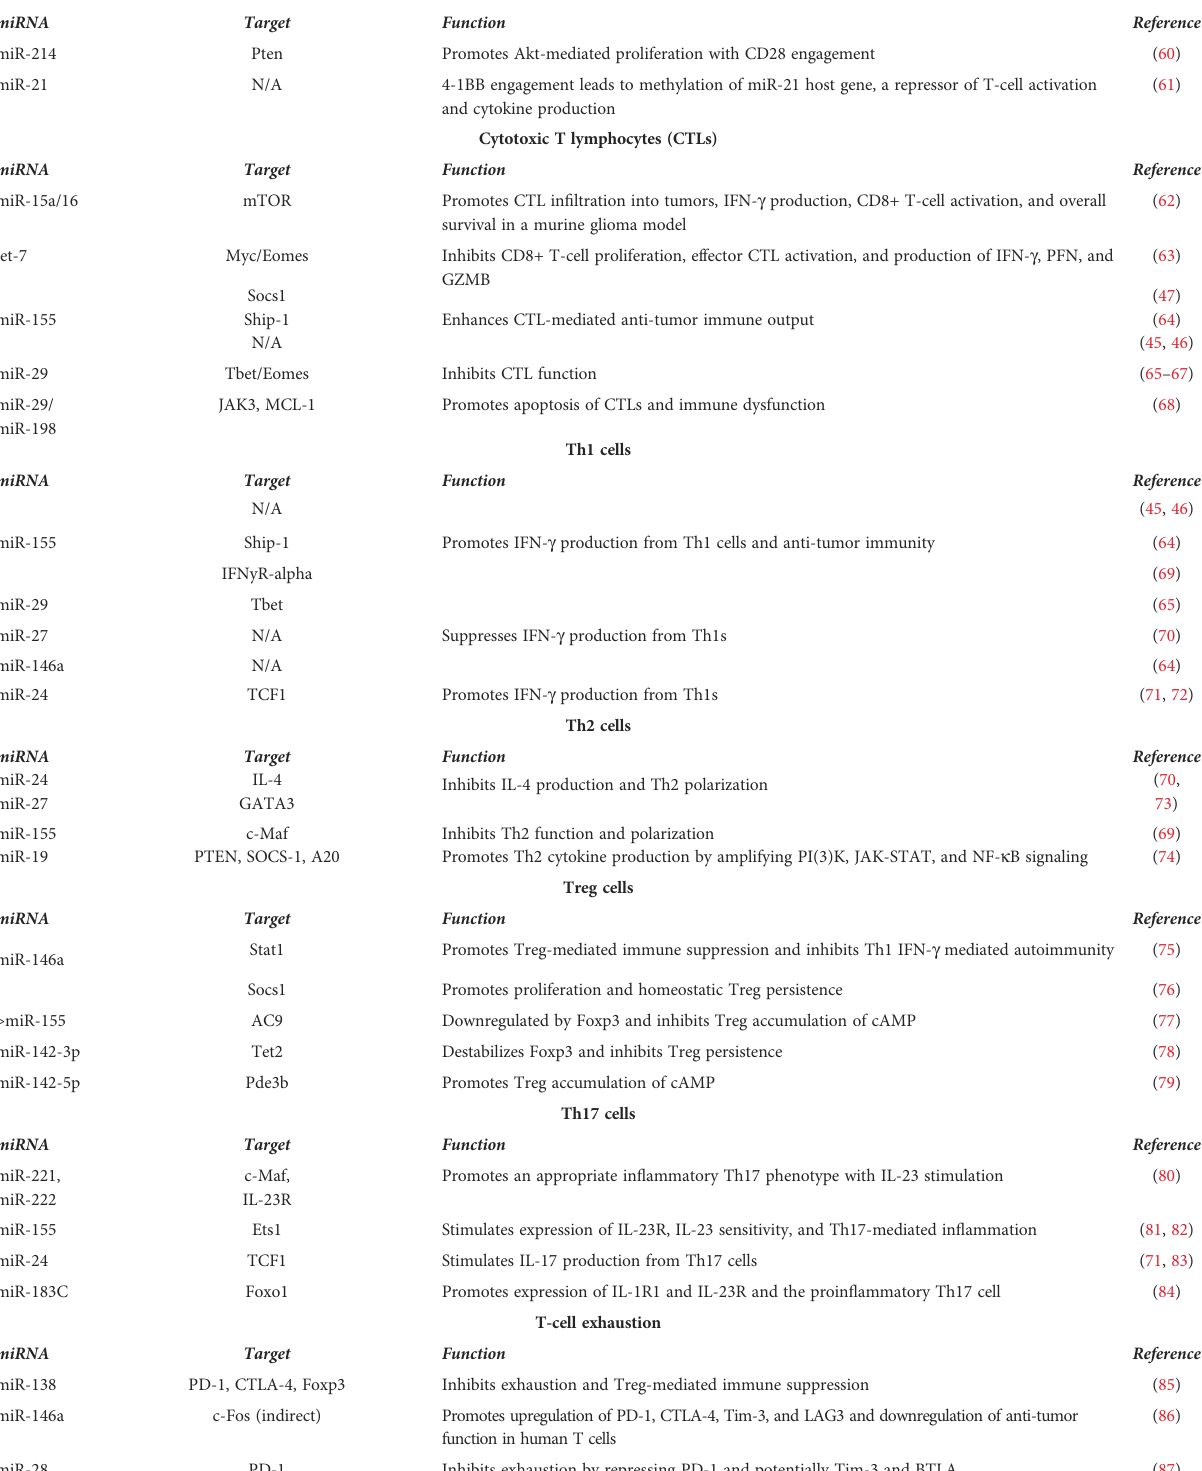
TABLE 1 T-cell miRNAs, targets, and